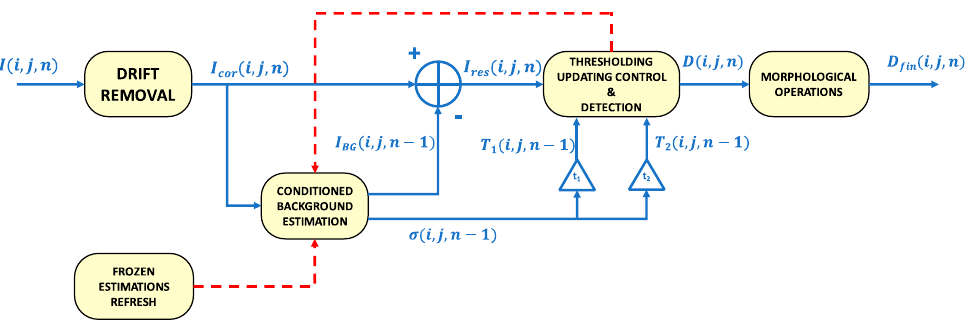
Figure 2. Block diagram of the proposed algorithm. Solid blue lines represent the flow of the video sequence frames, whereas dashed red lines represent the flow of the controls of the filter.